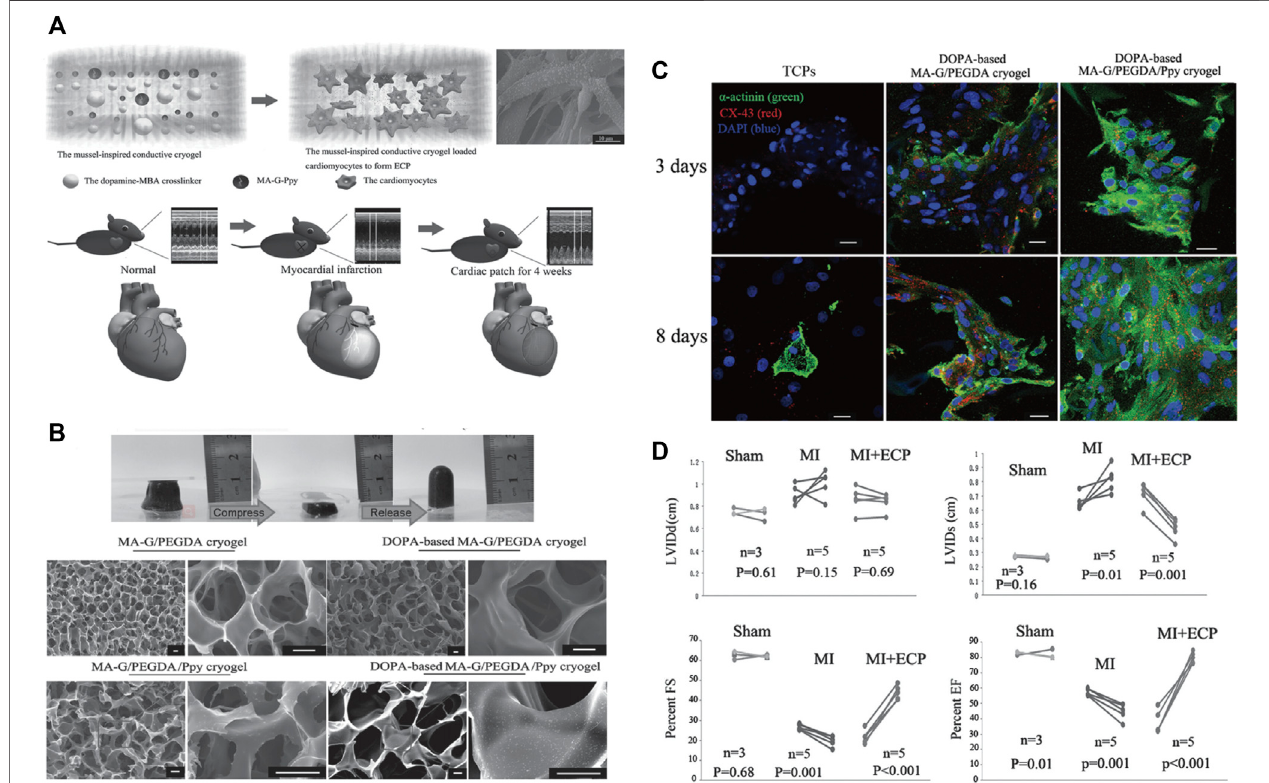
FIGURE 6 | Mussel-inspired conductive cryogel as a promising strategy for the restoration of infarcted myocardium. (A) Schematic illustration of the mussel- inspired conductive cryogel for engineered cardiac tissue patch in rat MI models. (B) Characterization and ultrastructure of the DOPA-based Ppy PEG-gelatin cryogel. (C) The DOPA-based MA-G/PEGDA/Ppy cryogel showed higher protein expressions of α -actinin and CX-43 in the cardiomyocytes presented by immuno fl uorescent staining. (D) The DOPA-based MA-G/PEGDA/Ppy cryogel signi fi cantly improved the cardiac functions of the mice after MI. Adapted with permission from Wang et al.,